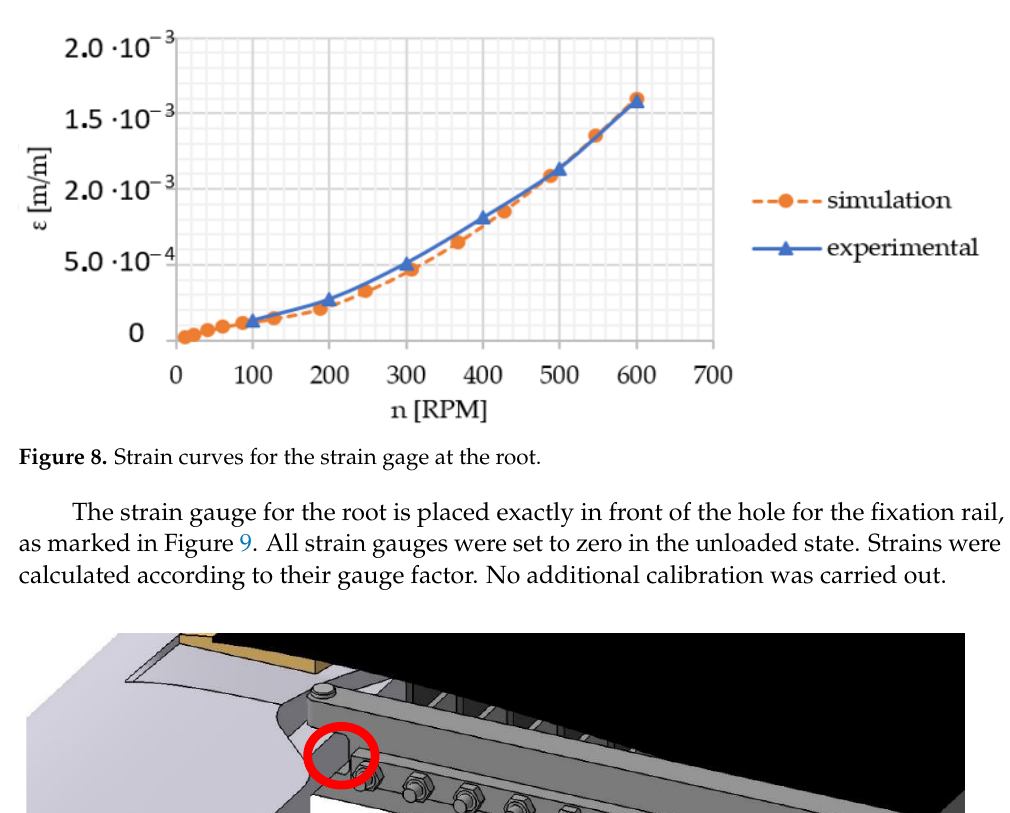
Figure 7. Complete demonstrator for chord morphing, installed in the test stand of the centrifugal tower.